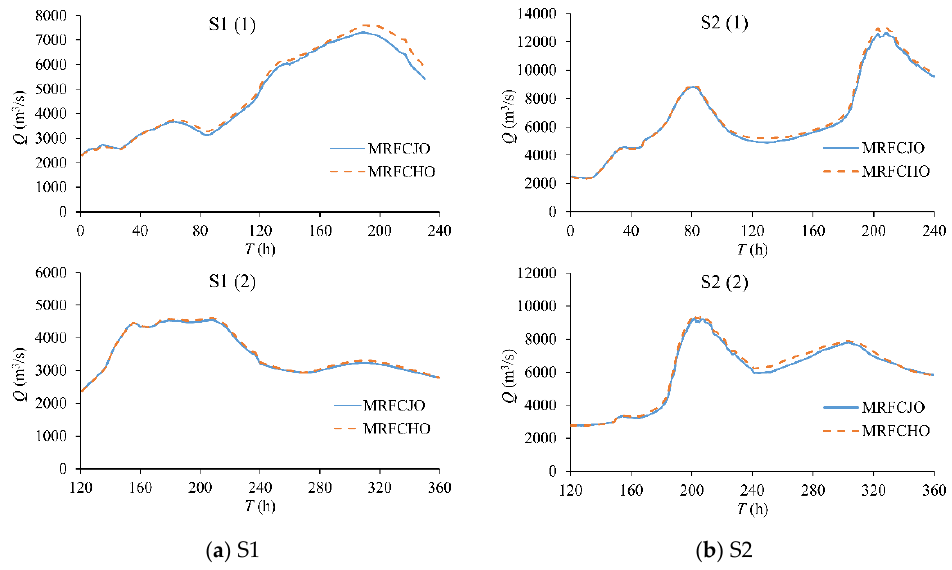
Figure 7. Flood hydrographs of ( a ) S1 and ( b ) S2 at the Lutaizi point. Table 4. Relative errors ( ε r ) of the peak discharge at the Lutaizi point.